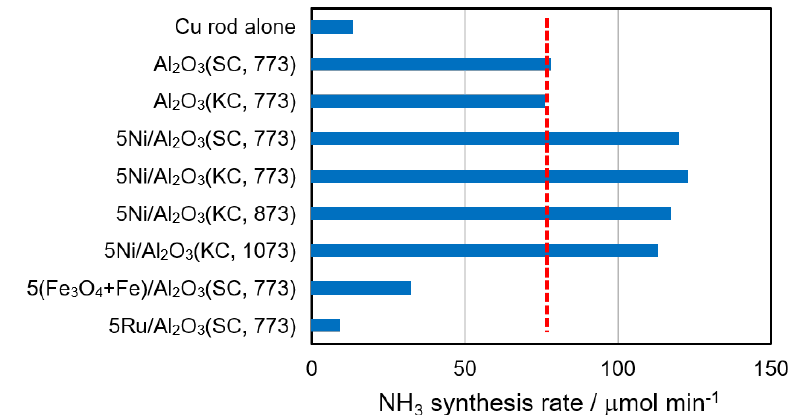
Figure 2. Comparison of activities of Ni-, Fe-, and Ru-supported γ -Al 2 O 3 catalysts. The red broken line indicates the average activity of Al 2 O 3 (SC) and Al 2 O 3 (KC). Reaction conditions were the same as those in Figure